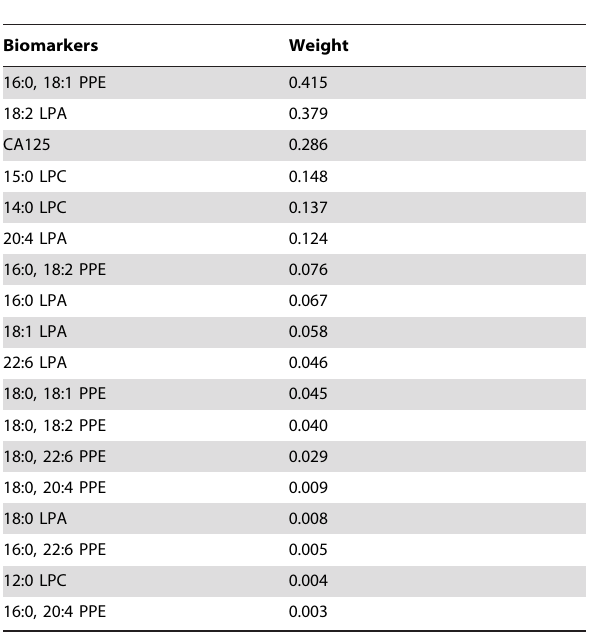
Table 2. Biomarkers ranked according to weights generated by Huberized Hinge Support Vector Machine (HHSVM) for classification of benigns and cases.